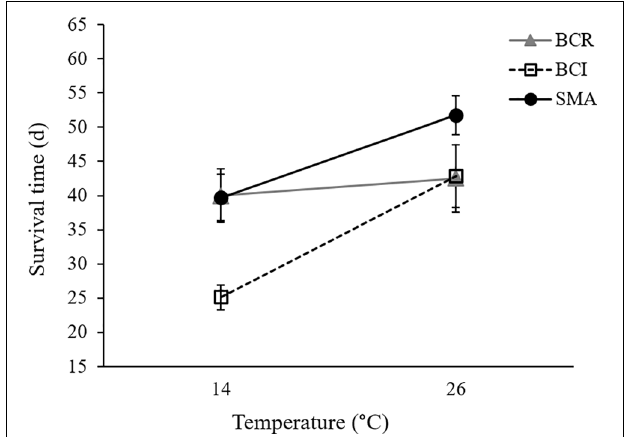
FIGURE 3 | Mean ( ± SE) survival time for Bd -exposed frogs in three bacterial manipulation groups (BCR, bacterial community reduced; BCI, bacterial community intact; and SMA, S. maltophilia added) at 14 and 26 ◦